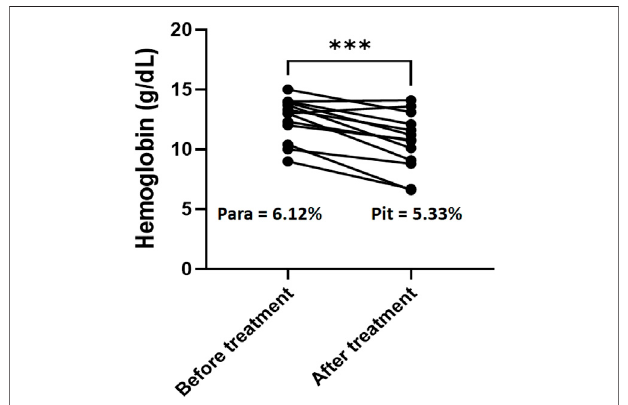
FIGURE 1 | Hemoglobin decline and RBC clearance. Hemoglobin concentration for the 13 patients with Hb data available both before and after therapy. Paired t-test, p value for hemoglobin comparison = 0.0003. Para: mean parasitemia for the same patients before treatment with AD.; pit: mean pittemia for the same patient after treatment with